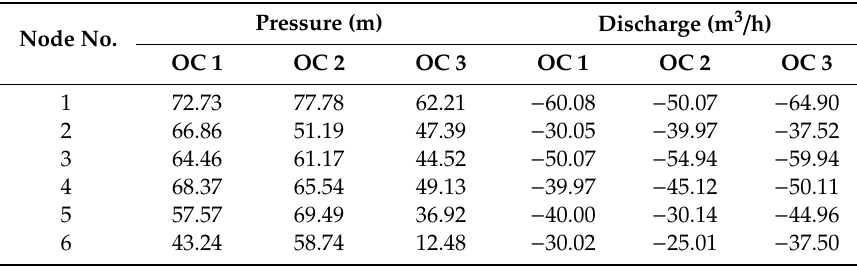
Table 4. Operating data with errors (error range =